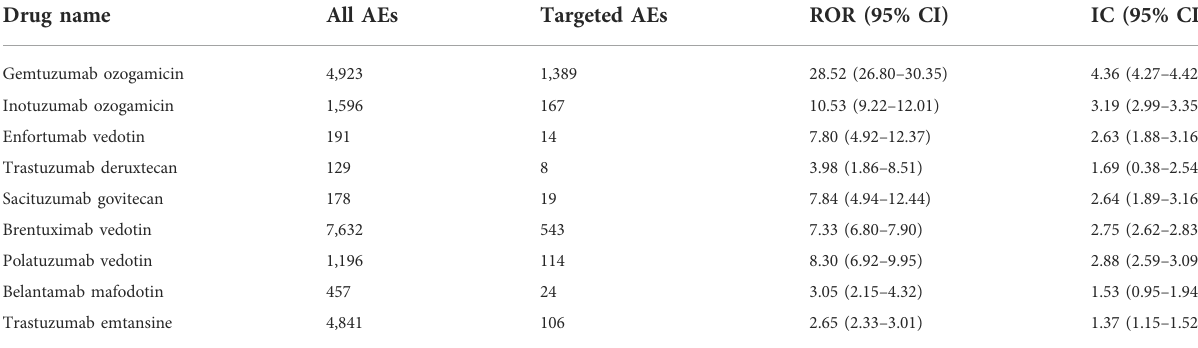
TABLE 4 Safety signals among different ADC drugs (vs. other drugs in the full database). Drug